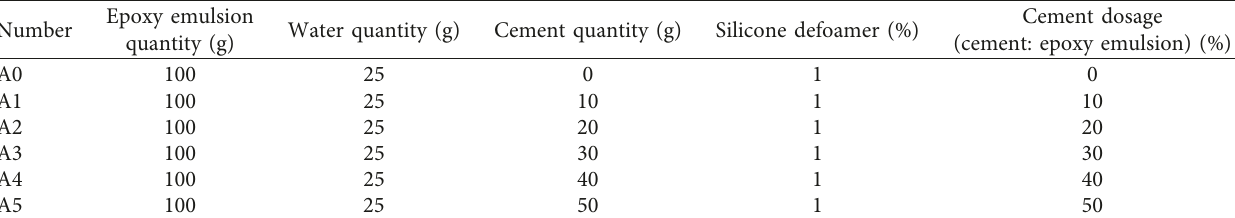
Figure 6: Microscopic view of carbonaceous mudstone under different immersion times. (a) Natural state ( × 1000 times). (b) The first day ( × 1000 times). (c) The second day ( × 1000 times). (d) The seventh day ( × 1000 times). (e) The second day ( × 3000 times). (f) The second day of the drying-wetting cycle ( × 3000 Table 1: Composition of the modified material.